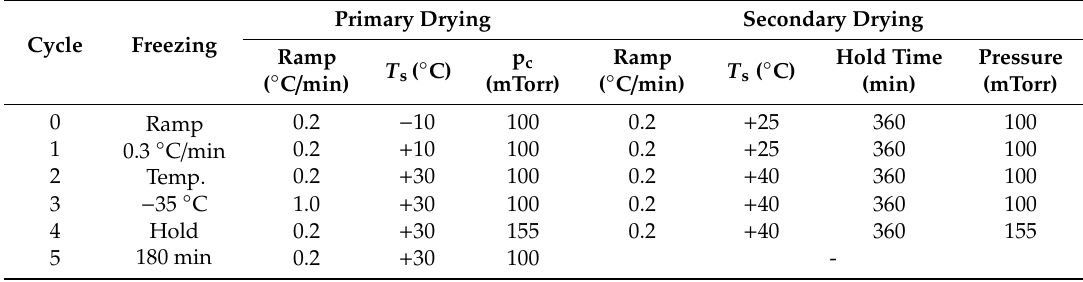
Table 1. Overview of process parameters of the di ff erent freeze-drying cycles employed. All cycles had a loading step of 60 min at 5 ◦ C prior to freezing. End of primary drying time was determined as ∆ p ≤ 1 mTorr between Pirani and capacitance c